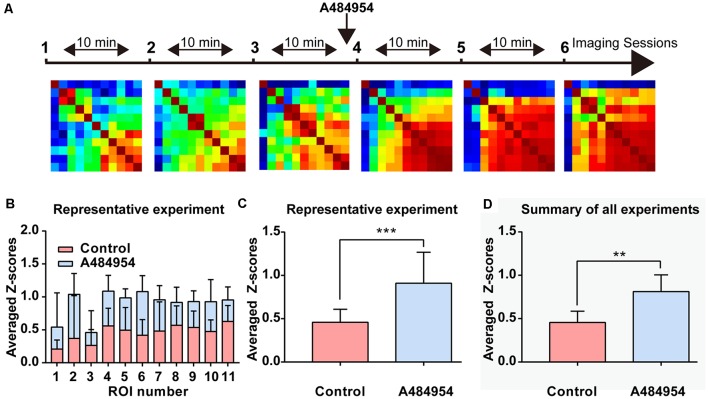
Detailed analysis of the effects of A484954 on MEC neurons. (A) The schema indicates the sequence of time-lapse imaging sessions. The first three sessions were under control conditions, and the last three sessions after A484954 application. Every session was a time-lapse acquisition of fluorescence for at least 1.5 min at 33 Hz. The heat maps represent the PCs of all ROI pairs with red larger than 0.8 and blue smaller than −0.8. The PCs increased after drug application gradually. (B) The averaged Z score (normalized PCs) of each particular ROI over is presented for the two conditions. (C) The averaged Z scores over all neuronal pairs and three sessions are shown for both conditions. The bar graph indicates the significant effect of the drug on the synchronization of paired fluorescence transients of different ROIs (control, 0.46 ± 0.05; A484954, 0.91 ± 0.10, ***P < 0.01, paired t-test). (D) The averaged Z scores of all neuronal pairs and three sessions were averaged with the values from all experiments (n = 4). The drug effect was significant (control, 0.46 ± 0.04; A484954, 0.81 ± 0.06, **P < 0.01, unpaired t-test, n = 4 slices).